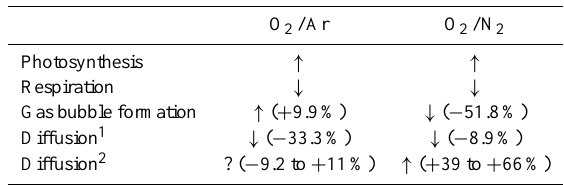
Table 2. Synthesis on the trends of changes of O 2 /Ar and O 2 /N 2 at the ice–water interface. An upward arrow indicates that the pro- cess increases the ratio, while a downward arrow indicates that the process decreases the ratio. The percentages in brackets indicate the maximal changes of the ratio associated with the physical processes (see Sect. 4.6.2 for